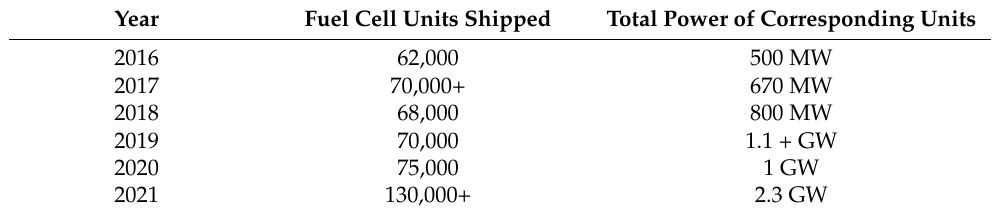
Table 11. Worldwide shipment of fuel cell